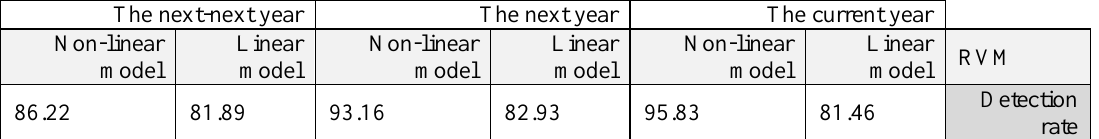
Table 6: The mean of RVM Linear and Nonlinear Model Detection Rate for Predicting the Bankruptcy of Companies for Test